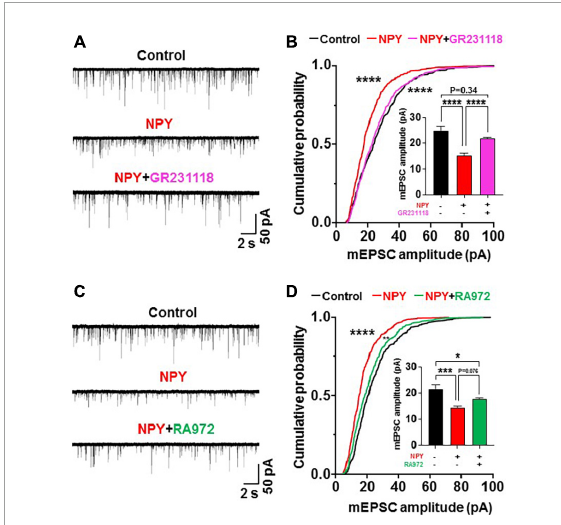
FIGURE4 Neuropeptide Y (NPY) depresses miniature excitatory postsynaptic current (mEPSC) by interacting with Y1 receptor (Y1R) but not Y5R. Hypothalamic slices from OXT mRFP rats were pretreated for 3 h with NPY in the absence and presence of the Y1R or Y5R antagonist. (A) Incubation with NPY depressed mEPSC, and this effect was blocked by simultaneous treatment with the Y1R antagonist GR231118 (0.5 µ M). (B) Incubation with NPY left-shifted the cumulative probability distribution and reduced the average of mEPSC amplitudes (insert). These effects were blocked by simultaneous treatment with GR231118. n = 8–9. **** P < 0.0001 between control vs. NPY and NPY vs. NPY + GR231118 by Kruskal-Wallis test followed by post-hoc Dunn’s test. In insert **** P < 0.0001, and P = 0.34 between control vs. NPY + GR231118 by one-way ANOVA followed by post-hoc Tukey’s test. (C) NPY without and with Y5R antagonist